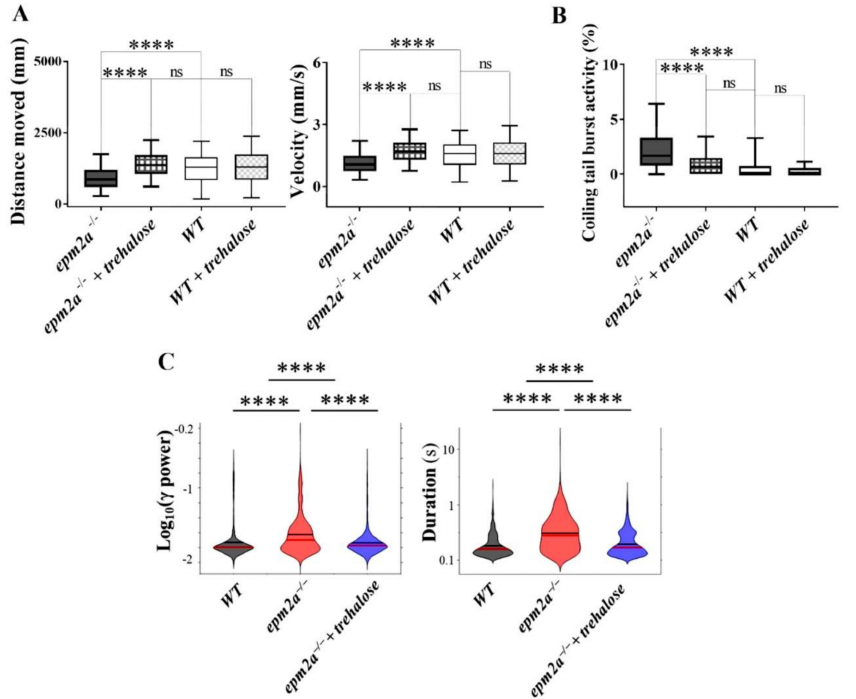
Figure 8. Locomotor, LFP and burst activity recordings after trehalose administration. ( A ) Locomotion analysis at five dpf in controls (WT) treated ( n = 172) and untreated with trehalose ( n = 193) and in epm2a − / − mutant larvae treated ( n = 213) and untreated with trehalose ( n = 228). Statistical analysis (**** p ≤ 0.0001) was performed using the Kruskal-Wallis test. Dunn’s test was used to perform post-hoc analysis for multiple comparisons after the Kruskal-Wallis test. ( B ) Tail flick analysis performed at 30 hpf in controls (WT) treated ( n = 91) and untreated with trehalose ( n = 87) as well as in epm2a − / − mutant larvae treated ( n = 106) and untreated with trehalose ( n = 111). Statistical analysis (**** p ≤ 0.0001) was performed using the Kruskal-Wallis test. Dunn’s test was used to perform post-hoc analysis for multiple comparisons after the Kruskal-Wallis test. ns, not significant ( C ) Violin plot of the effect of trehalose on the power and duration of detected events, 11 larvae per group were analyzed at five dpf. Statistical analysis (**** p ≤ 0.0001) was performed using the Mann-Whitney